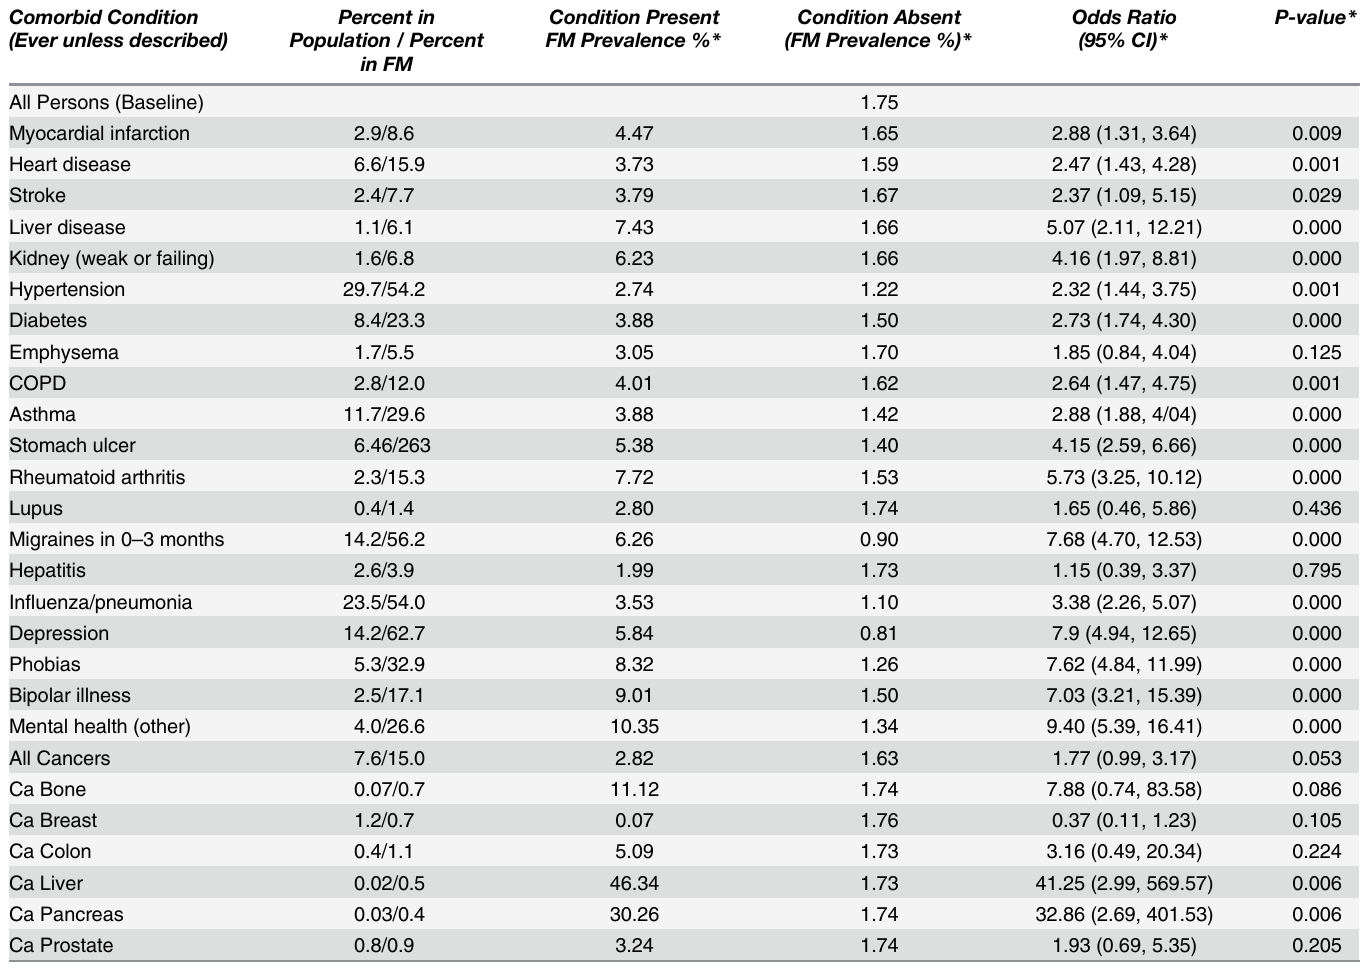
Table 3. Comorbid medical and psychiatric illness association with